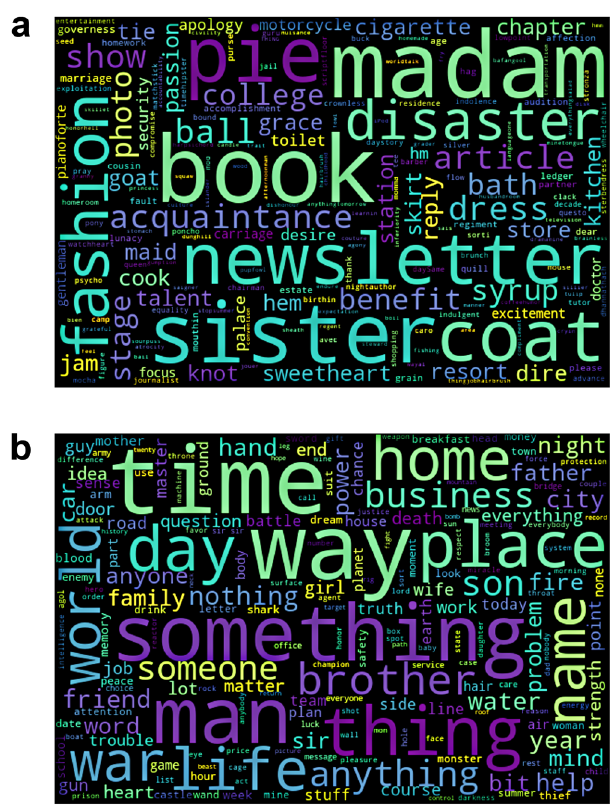
Fig. 9 Distribution of non-overlapping nouns in the dialogues of female and male characters. a Female, b Male.